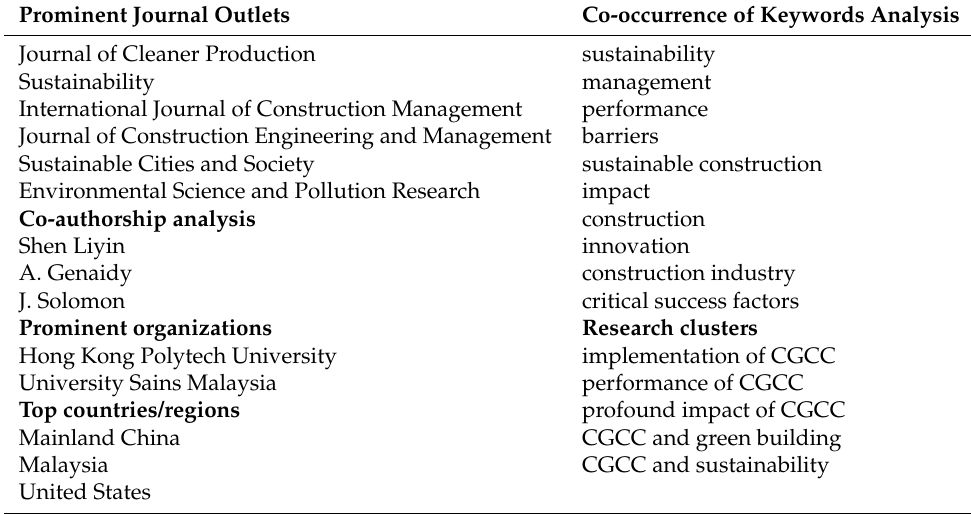
Table 5. Summary of key